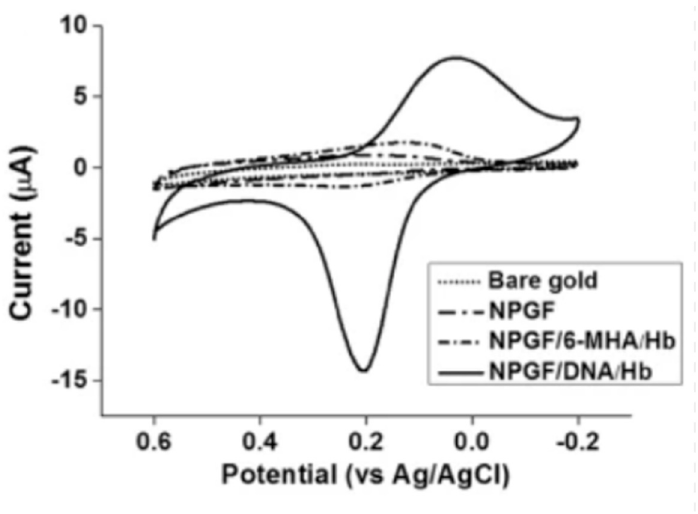
Figure 5. Cyclic voltammograms of bare gold, a nanoporous gold thin film (NPGF) electrode, NPGF/6-MHA/Hb and NPGF/DNA/Hb in PBS